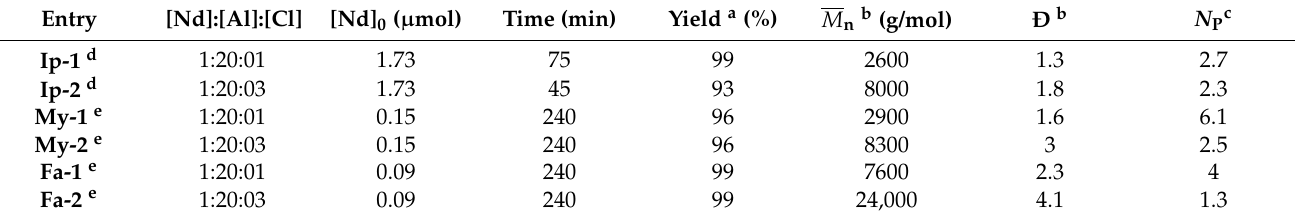
Table 1. Polymerizations initiated by NdV 3 /Al(i-Bu) 2 H/Me 2 SiCl 2 in cyclohexane at 70 ◦